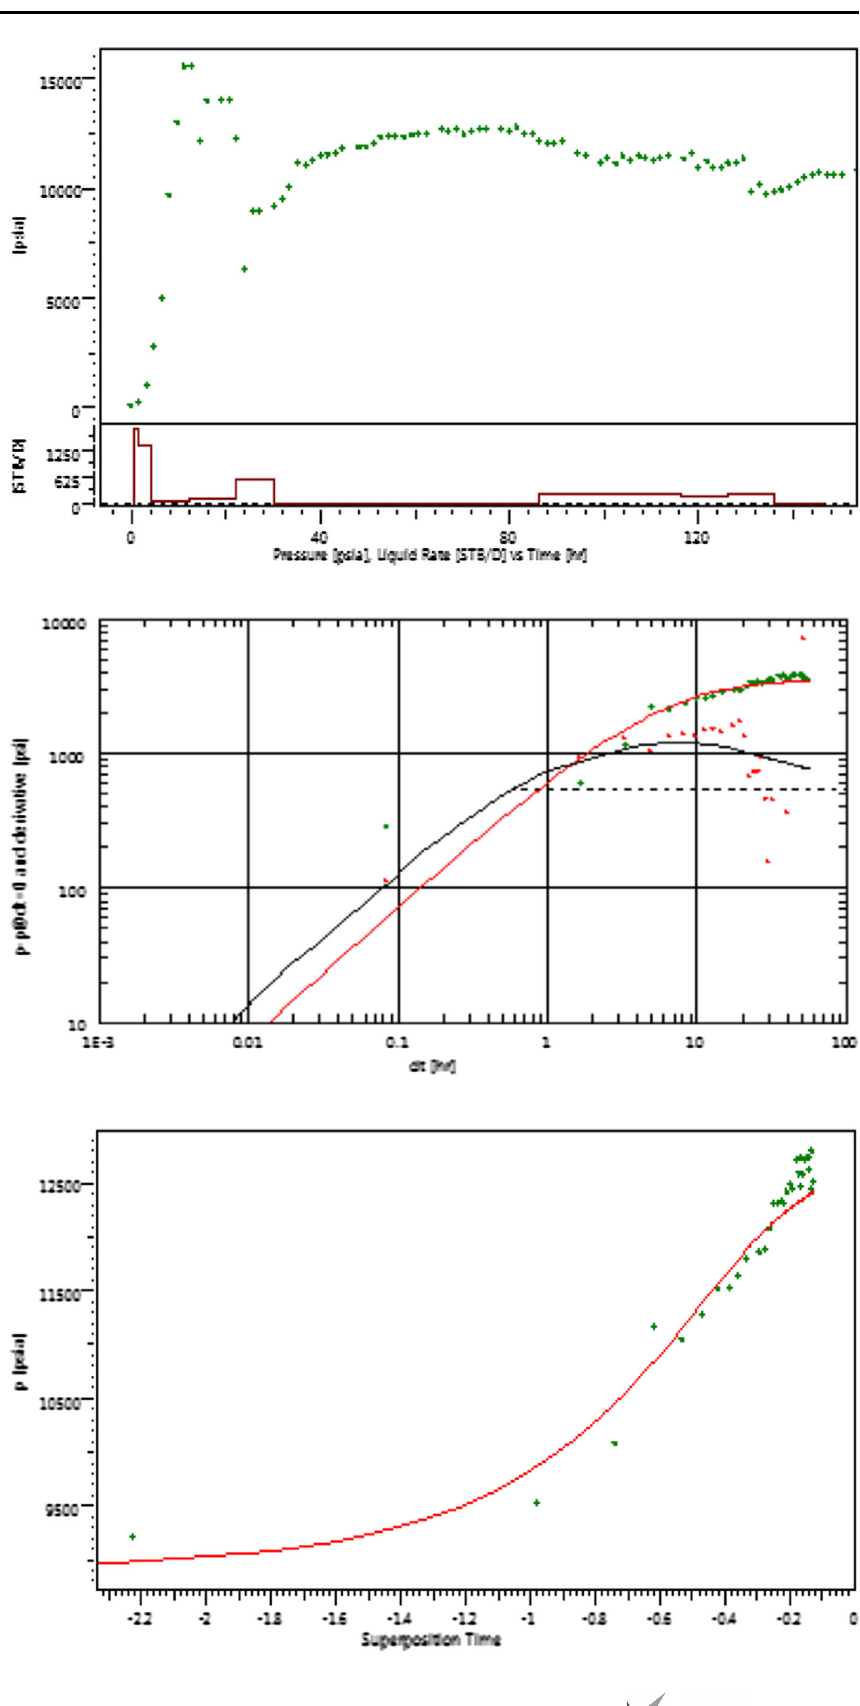
Fig. 2 History plot (pressure, rate vs. time)